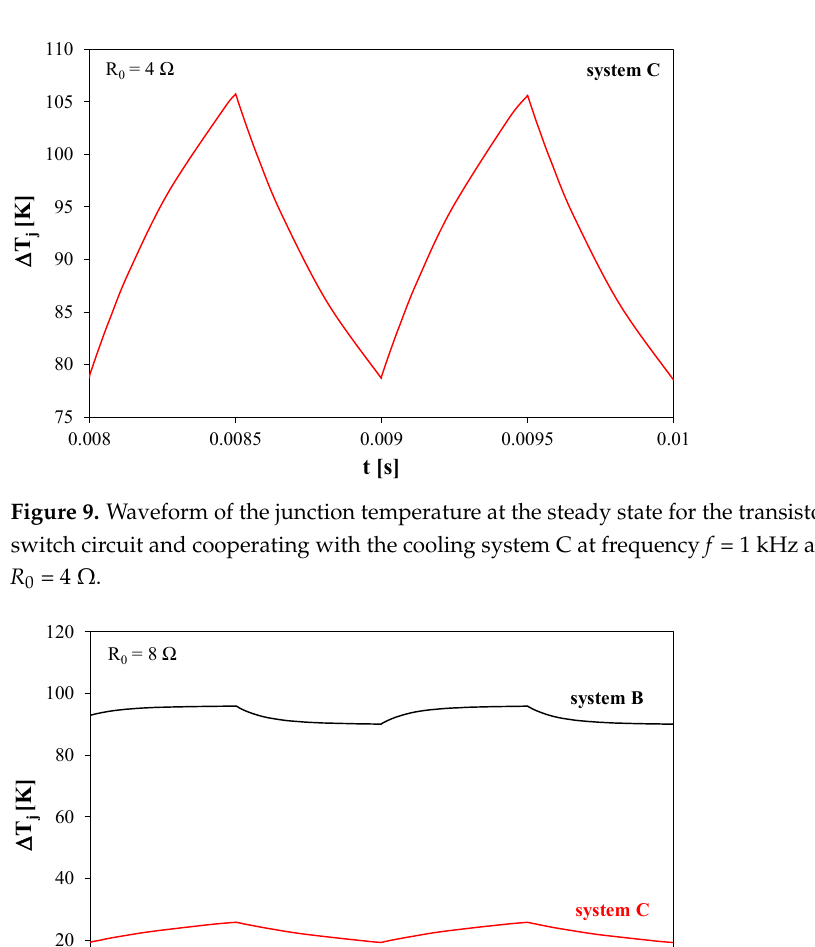
switch circuit and cooperating with the cooling system C at selected frequency values.